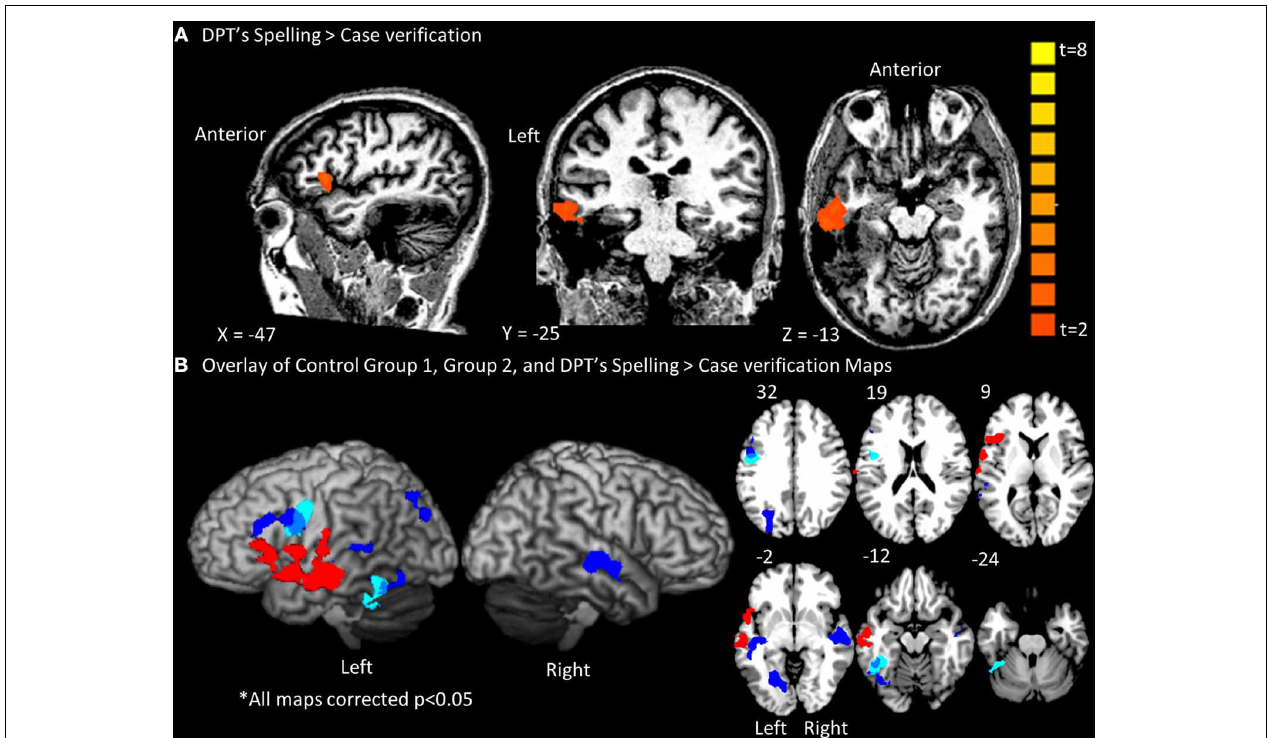
FIGURE 3 | Whole brain contrast maps depicting spelling activations for DPT and the control groups. Only clusters surpassing a corrected cluster-threshold of p < 0 . 05 are shown. (A) Map of clusters with t -value scale for the Spell > Case Verification for DPT (B) Map of DPT’s spelling clusters projected in red onto a standard rendered template